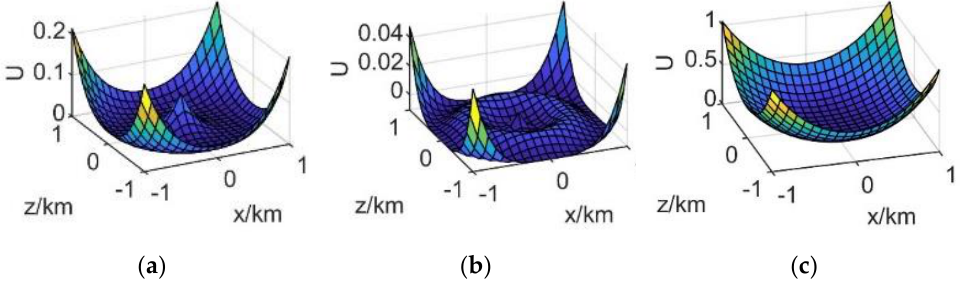
Figure 8. Bifurcating potential field ( k f = 1 kg/kms 2 , a = b = 1). ( a ) Circle potential field ( r = 0.6 km,